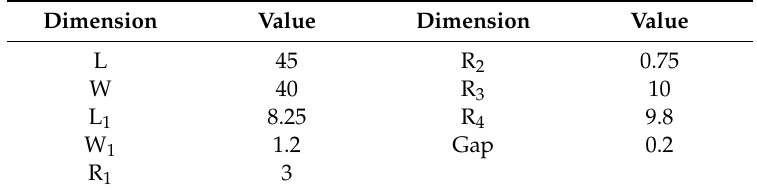
Figure 1. Evolution of the proposed configuration: ( a ) conventional Vivaldi antenna; ( b ) slotted Vivaldi antenna; and ( c ) semicircular patch embedded Vivaldi antenna (SPEVA). Table 1. Design parameter and their values of the proposed three antennas. All physical dimensions are in